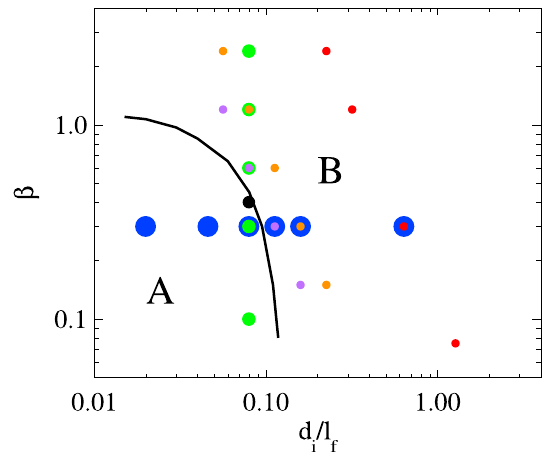
Fig. 1. Parameter plane (d i /l f ,β) where the various colors refer to the series of runs discussed in the text. This plane is divided into two regions displaying a different heating dynamics: in region A, ion parallel heating dominates, while in region B, perpendicular heating and parallel cooling take place.